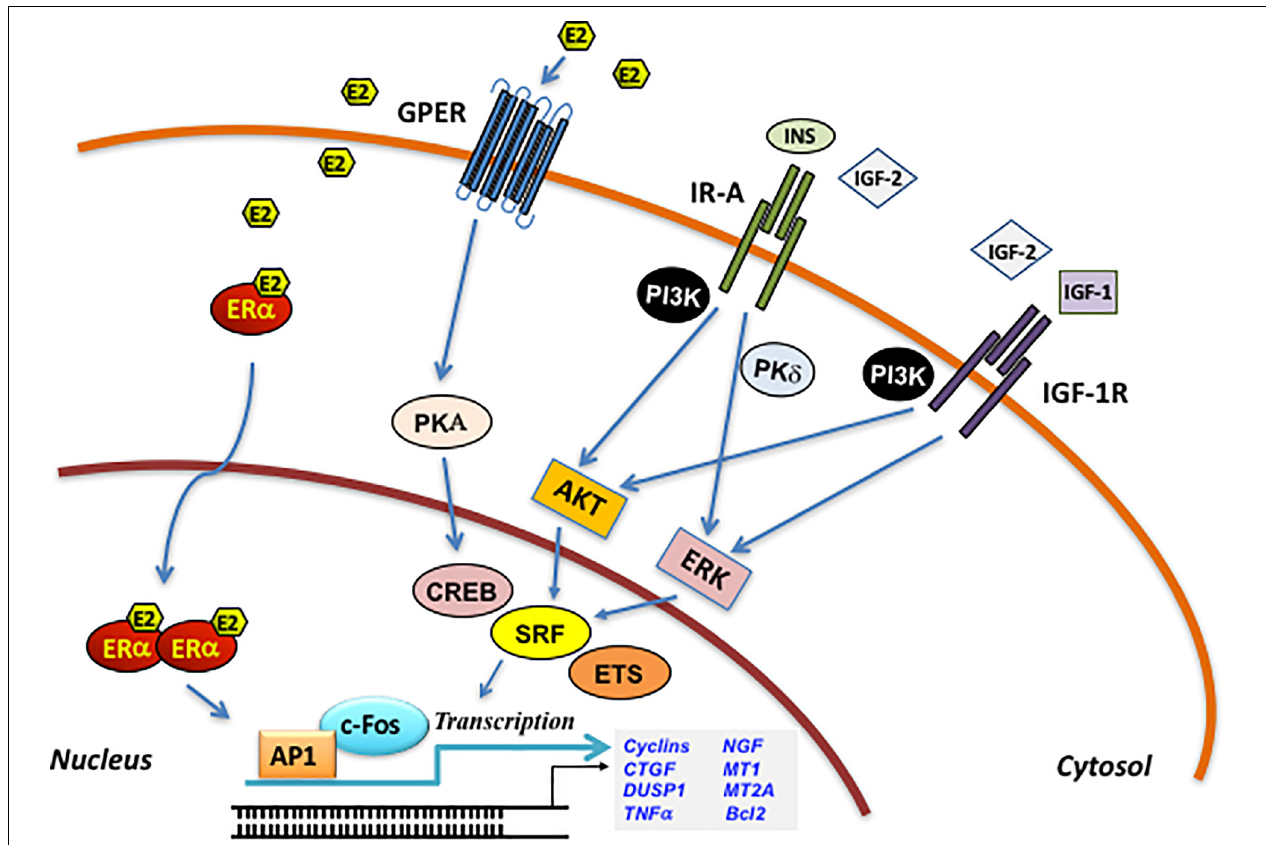
FIGURE 1 | Schematic illustration of the ER α /GPER and IIGFs cross-talk. Insulin, IGF-2, and IGF-1 bind to their specific receptors and stimulate rapid signals converging to the activation of PI3K, MAPK, and PK δ networks. These pathways, in turn, trigger the activation of transcription factors including CREB, SRF, and ETS, which favor c-fos induction and its recruitment to the AP-1 site. ER α /GPER activation by E2, through the activation of various intermediates, cross-talks with the IIGFs leading to enhanced mitogenic signals. PKA, protein kinase A; PKC δ , protein kinase C, δ isoform; MAPK, mitogen-activated protein kinases; PI3K, phosphatidyl-inositol-3-kinases; ERK, extracellular signal-regulated kinases; AKT, protein kinase B; CREB, cAMP-response element-binding protein; ETS, E26 transformation specific; SRF, serum response factor; c-fos, FBJ murine osteosarcoma virus; AP-1, activator protein-1; CTGF, connective tissue growth